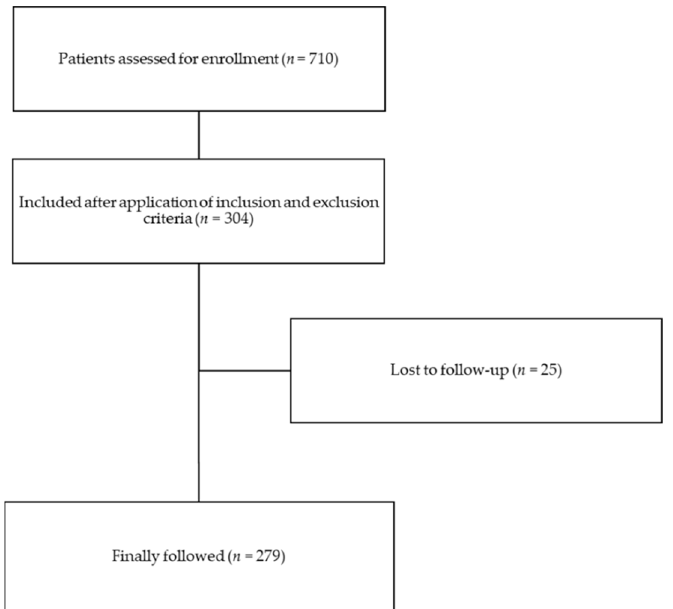
Figure 1. Flow-chart. Figure 1.